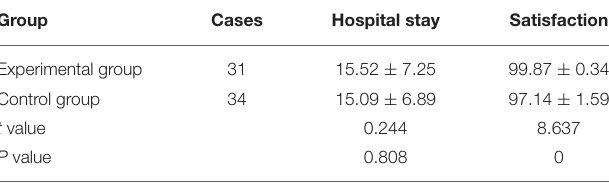
TABLE 5 | Comparison of hospital stay and satisfaction between the two